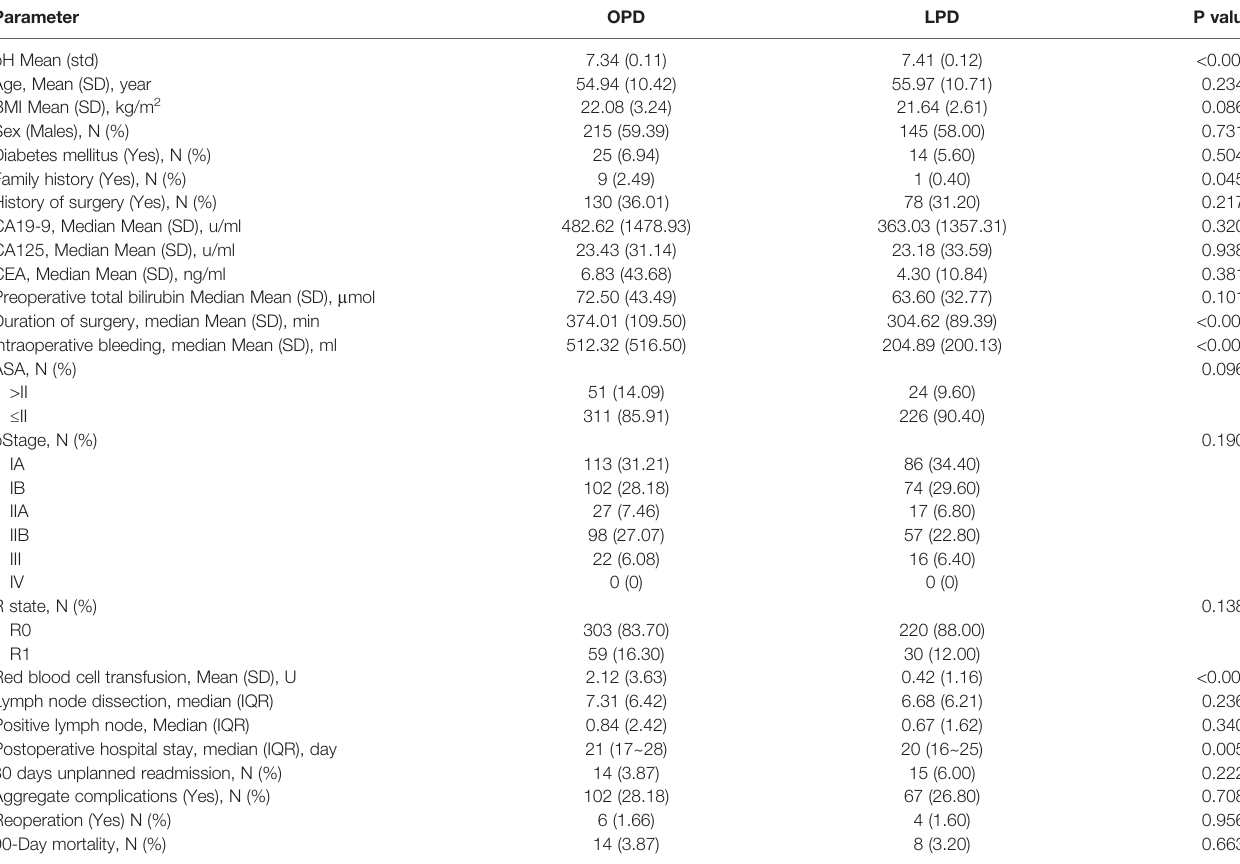
TABLE 5 | Comparison characteristics between laparoscopic pancreaticoduodenectomy (LPD) and open pancreaticoduodenectomy (OPD). Parameter OPD LPD P value pH Mean